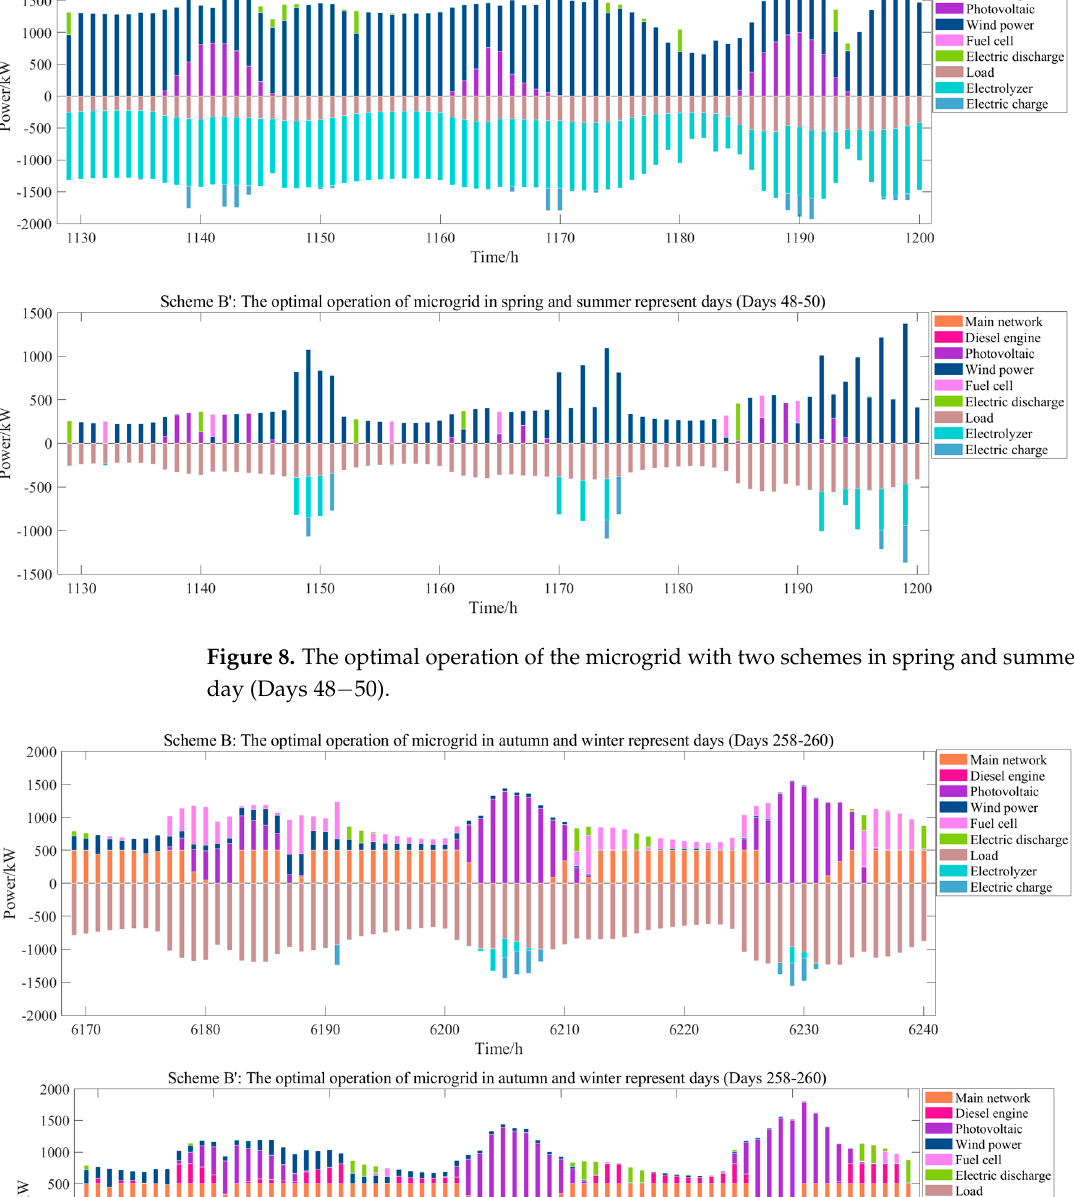
Figure 7. Annual reserve change of electric energy storage and hydrogen storage tanks in two schemes.